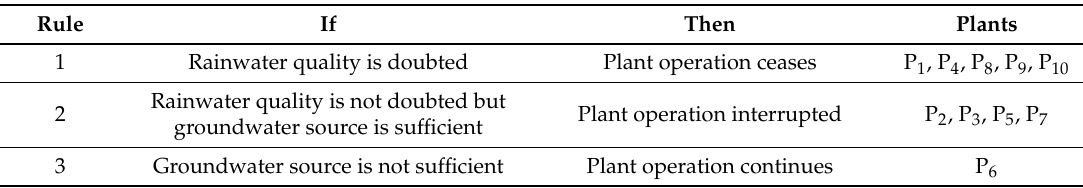
Table 6. Description of rules and plants